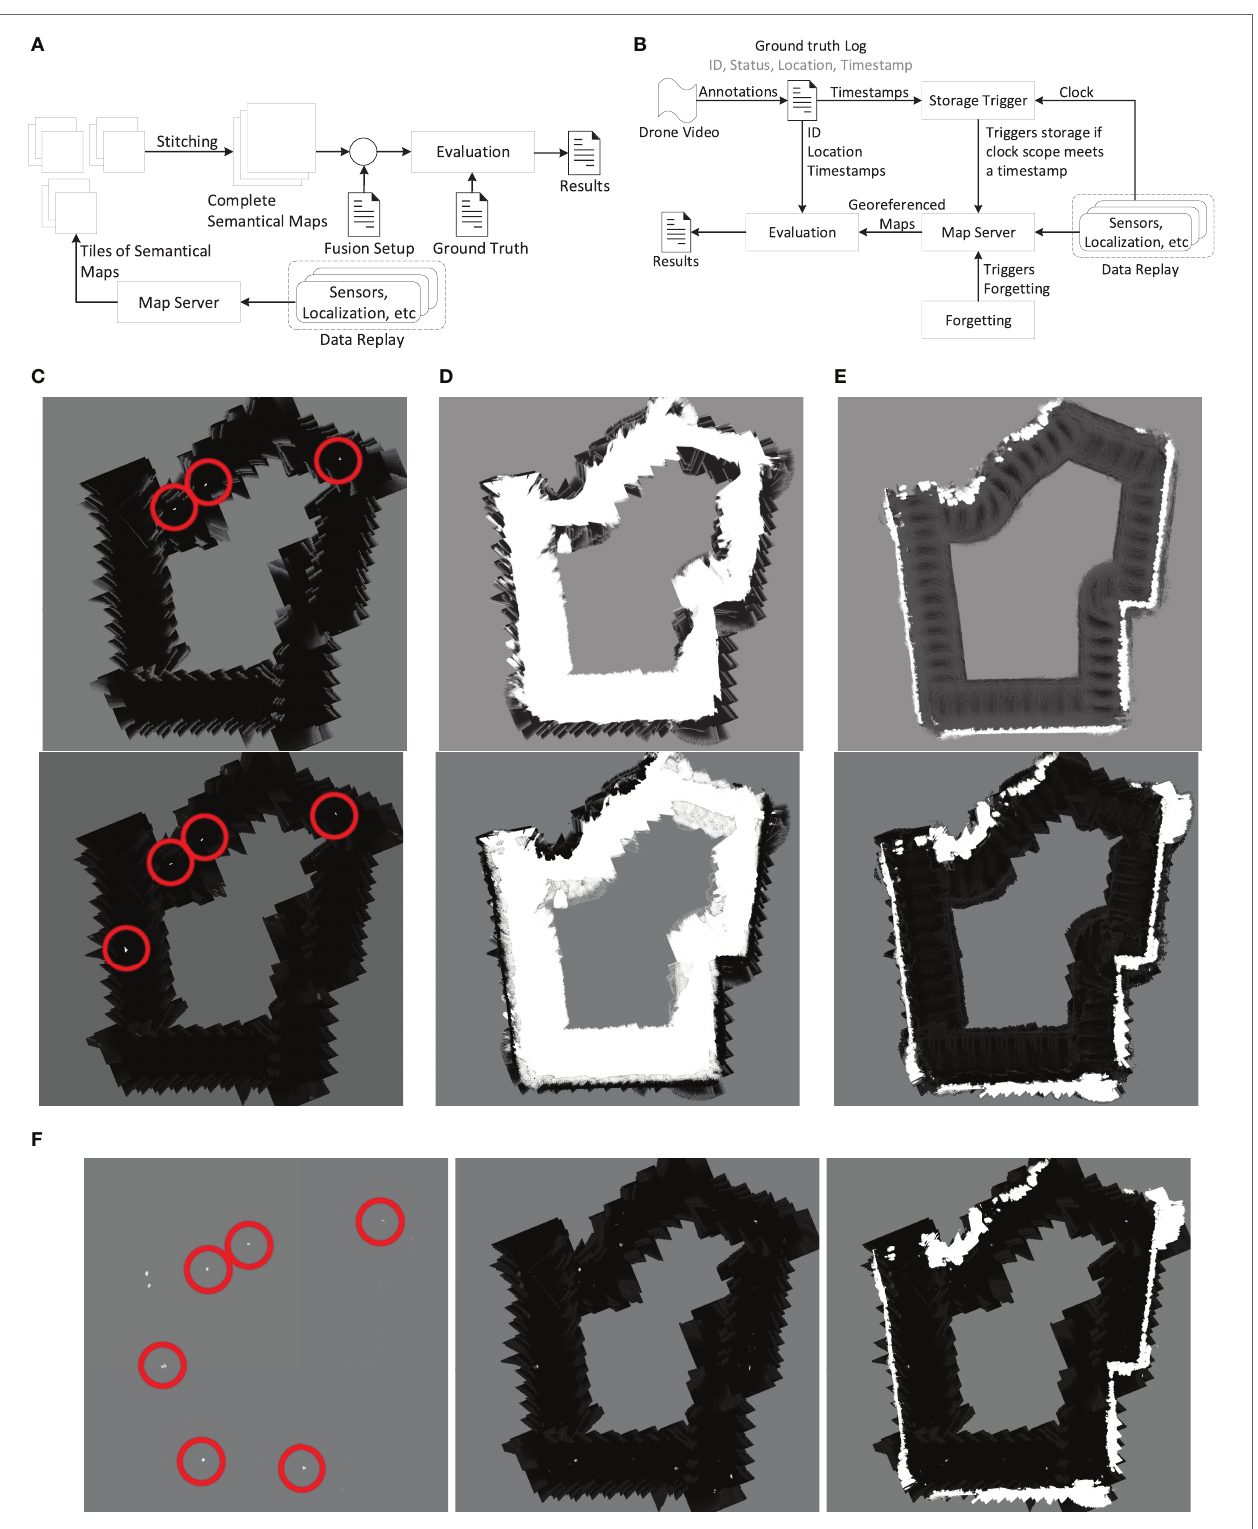
FIGURE 9 | Examples for different stitched mapping results for different evaluations of Table 2A (C–E) , Table 2B (F) , and evaluation pipelines (A,B) . Red circles emphasize correct object/mannequin detections. Grayscale encoding: black b = occupied , white b = unoccupied , gray b = unknown . (A) Evaluation pipeline from static recording to evaluation with stitching. (B) Evaluation pipeline from dynamic recording using drone video and recorded data as input. (C) cam-YOLO-human (top) and fused human class (bot.). (D) cam-FCN-ground (top) and fused ground class (bot.). (E) lidar-SVM-veg. (top) and fused vegetation class (bot.). (F) radar-tracking (left), Bayesian fusion among class (mid.), and complete fused map